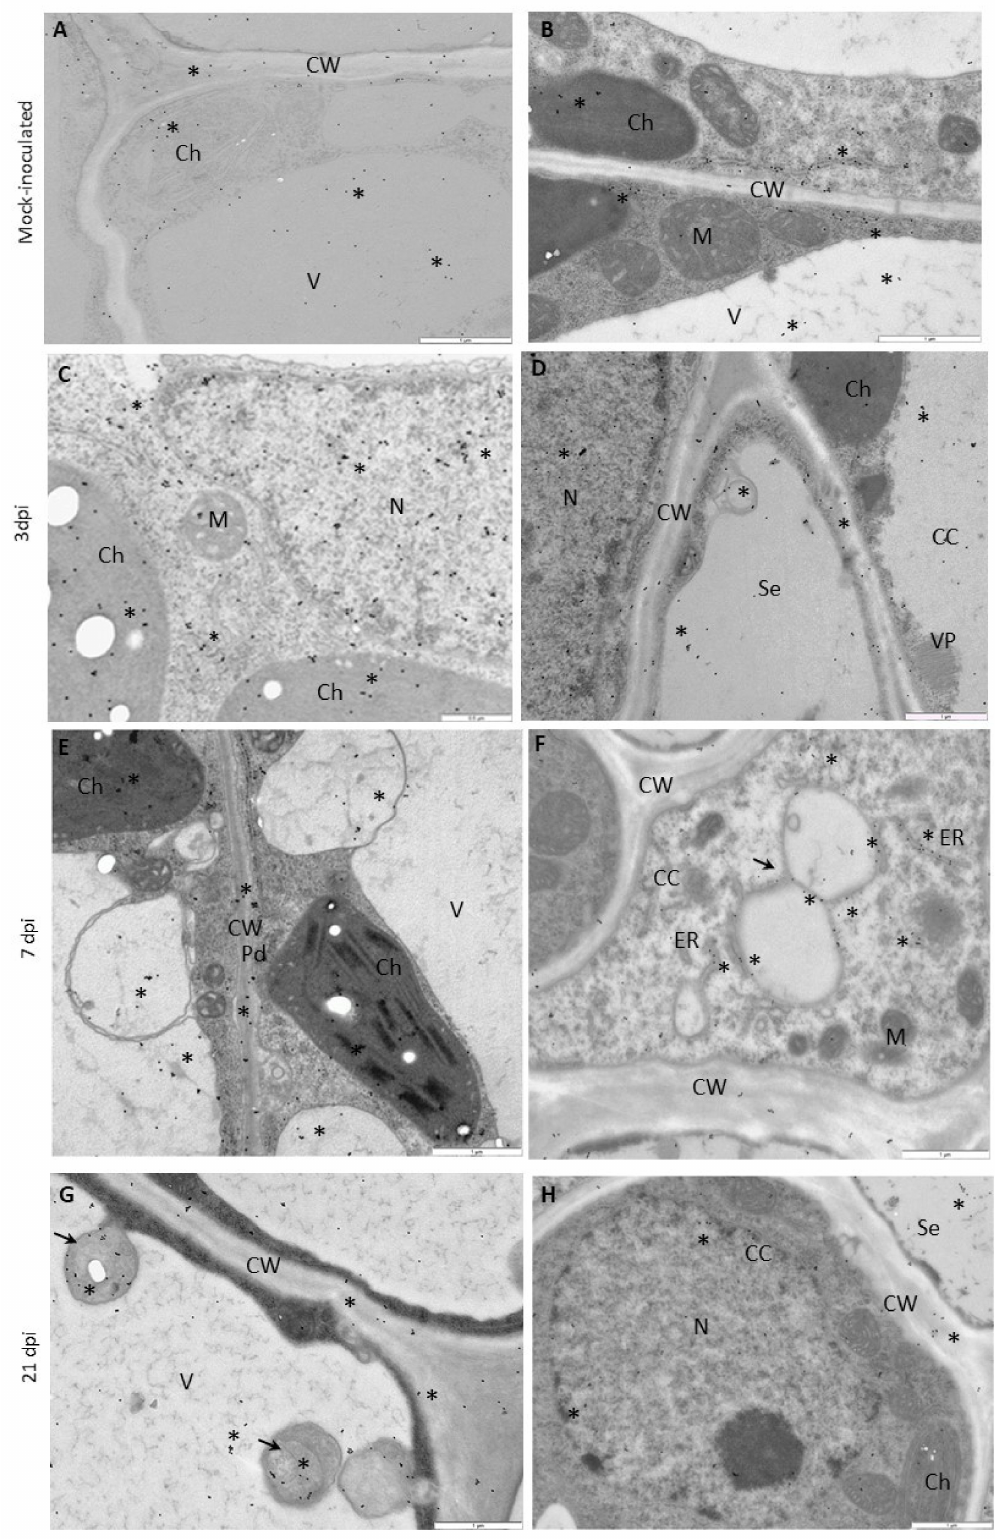
Figure 10. Immunogold localization of HSC70 in Irys and Sekwana leaves. ( A , B ) Mock-inoculated, ( C , D ) at 3 dpi, ( E , F ) at 7 dpi, ( G , H ) at 21 dpi. ( A ) HSC70 (*) in vacuoles (V), chloroplasts (Ch), and the cell wall (CW) of the phloem of mock-inoculated Irys plants. Scale bar: 1 µ m. ( B ) HSC70 (*) along the ER, in vacuoles (V) and chloroplasts (Ch) in the mesophyll of mock-inoculated Sekwana. Scale bar: 1 µ m. (C) HSC70 (*) in the nucleus (N), chloroplasts (Ch), and cytoplasm in mesophyll cells. Scale bar: 0.5 µ m. ( D ) HSC70 (*) in the sieve element (Se) and companion cell (CC). Gold granules in